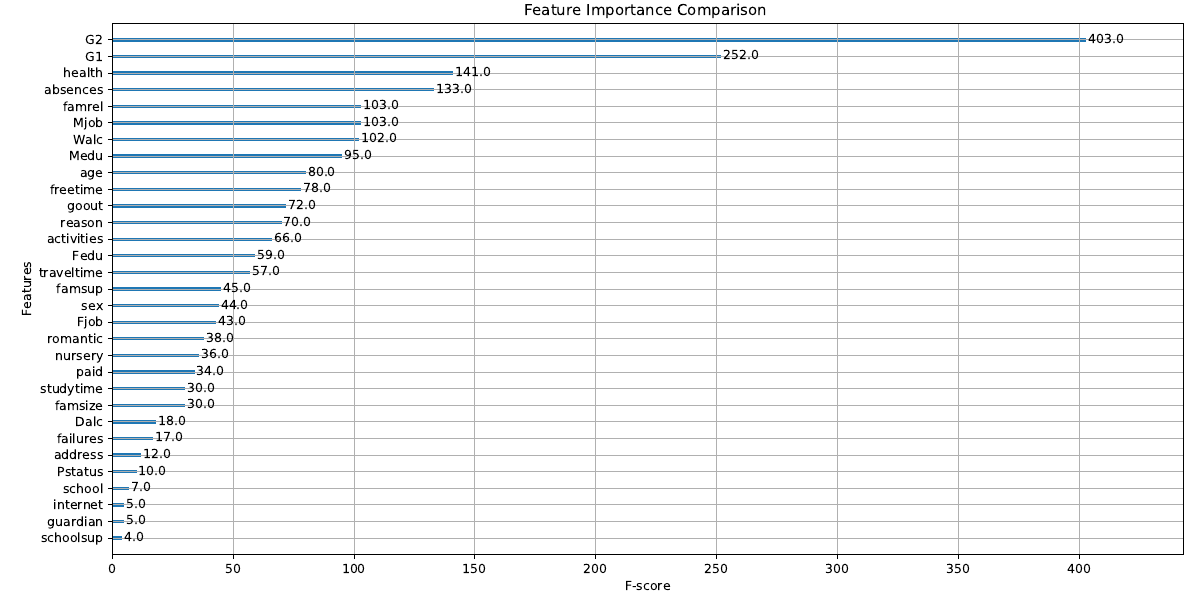
Figure 11. Feature importance comparison of student